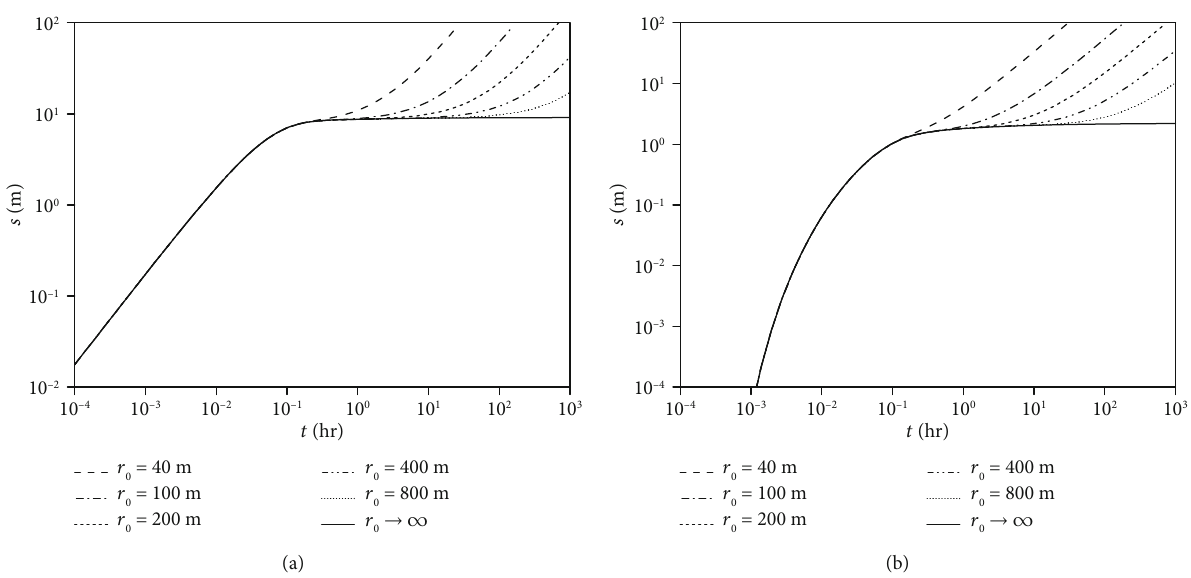
Figure 4: Impact of outer boundary on the drawdown in pumping well (a) and aquifer (b).